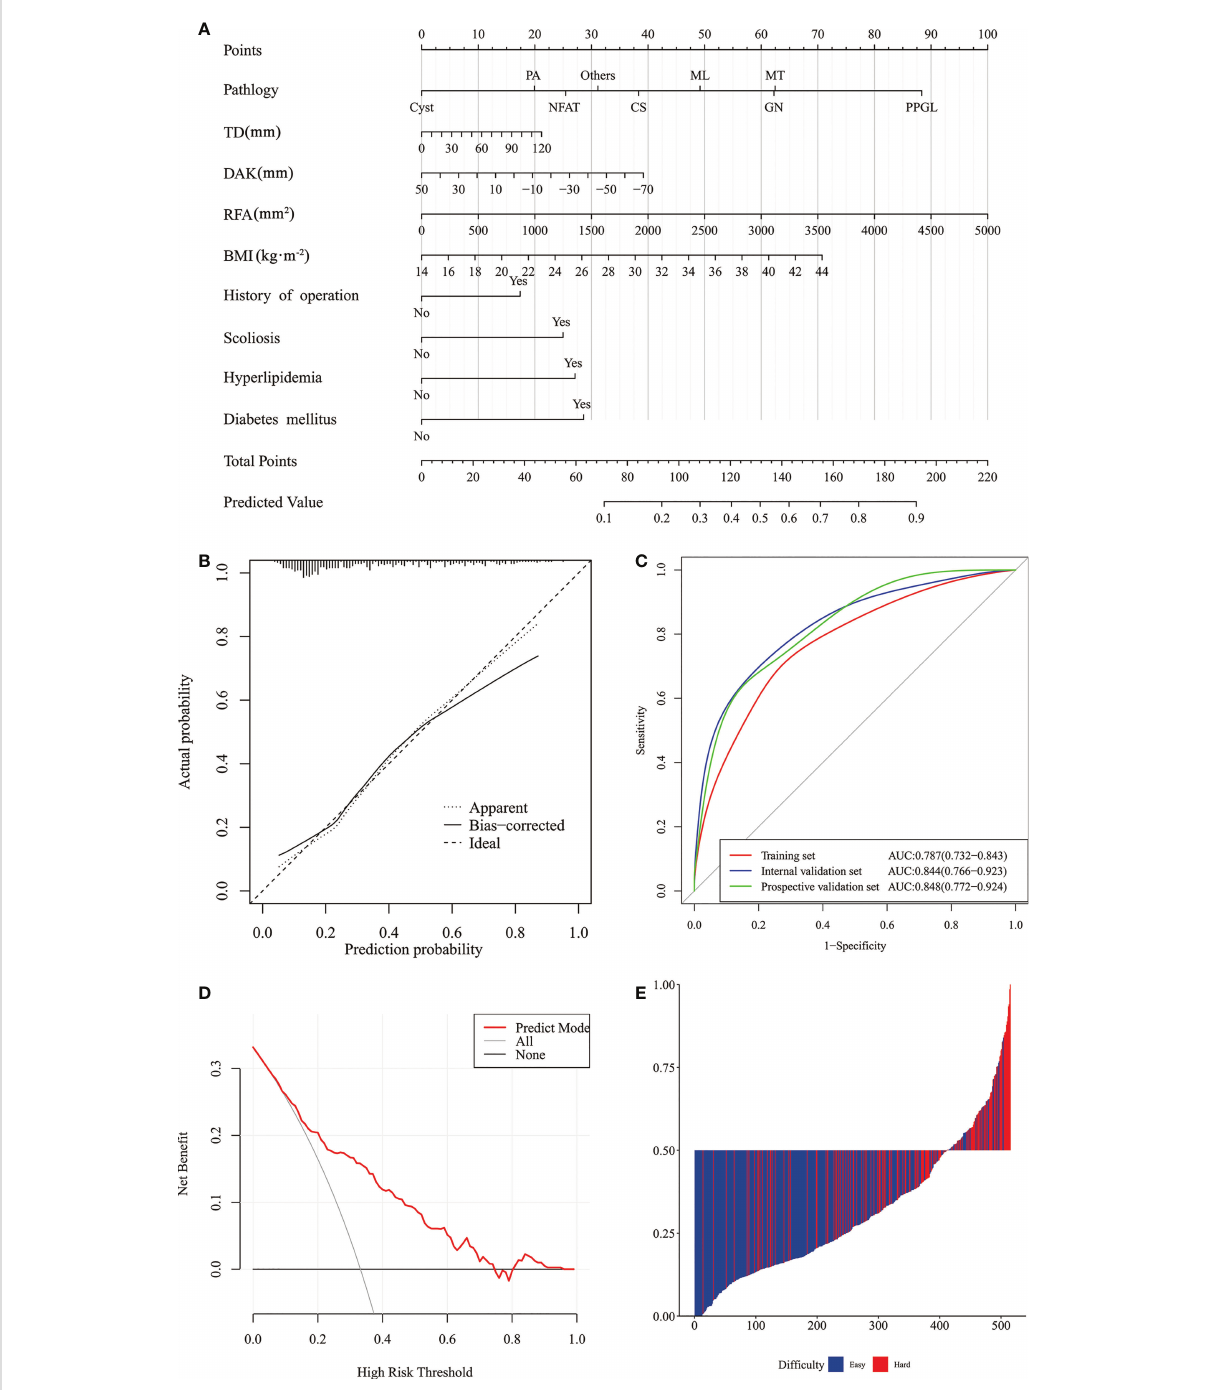
FIGURE 4 Nomogram of prediction model of dif fi culty of retroperitoneal laparoscopic adrenalectomy and its performance. (A) Nomogram. (B) Calibration curves of the nomogram in the training and internal validation sets. (C) ROC curves of the nomogram in the training, internal and prospective validation sets. (D) Clinical decision curve analysis of prediction model. (E) The calculated risk scores for each patient within the combined training and external validation datasets.) (NFAT, non-function adrenal tumor; PA, primary aldosteronism; PPGL, pheochromocytoma and paraganglioma; Others, include eosinophil tumor, teratoma, schwannoma, hematoma, tuberculoma, foreign body granuloma, retroperitoneal bronchial cyst, and hemangioma; MT, Malignant tumor, include adrenocortical carcinoma and adrenal metastasis; TD, tumor diameter; DAK, distance from adrenal tumor to upper pole of kidney; RFA, retrorenal fat area; BMI, body mass